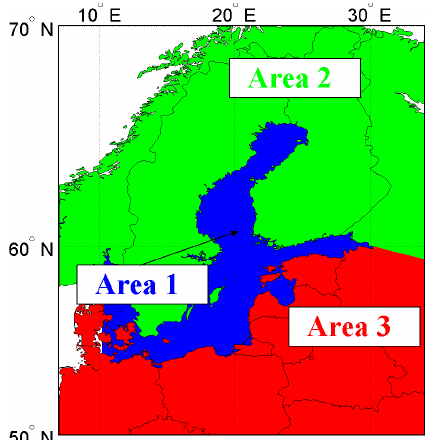
Figure 1. The area covered in this study and its division into three subregions: Area 1, the Baltic Sea, is represented by the colour blue; Area 2, covering the land areas of Fennoscandia, is represented by the colour green and Area 3, in red, includes the land areas of central–eastern Europe.